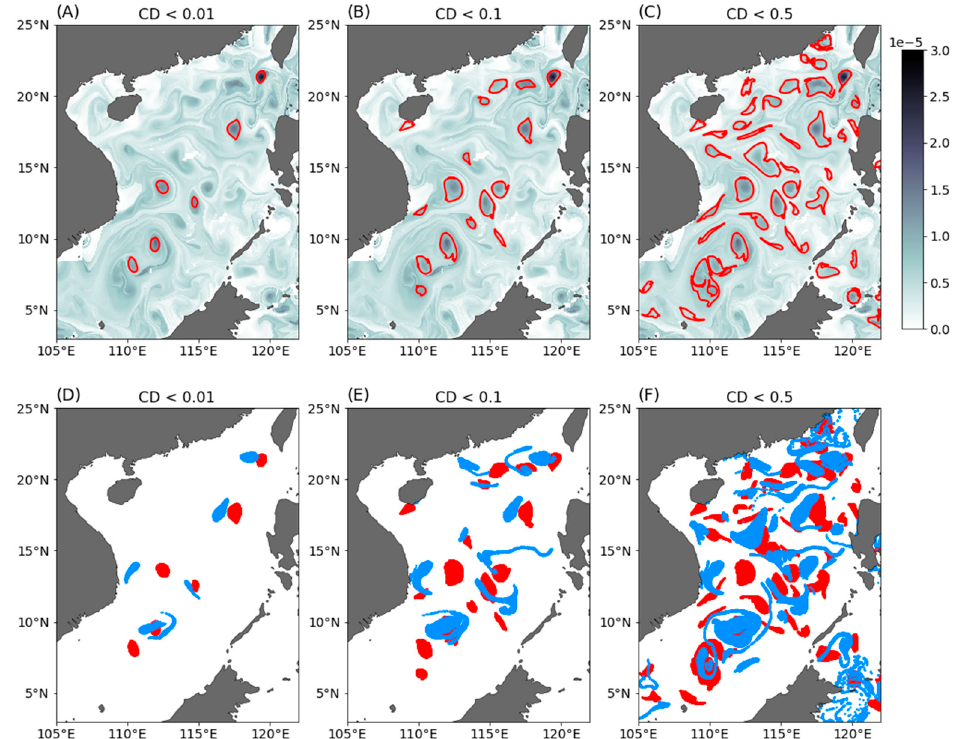
Figure A1. LAVD fields (colors) and 30-day Lagrangian eddy boundaries (red lines) for ( A ) CD < 0.01, ( B ) CD < 0.1, and ( C ) CD < 0.5 in a random time interval. Initial (red dots) and final (blue dots) locations for ( D ) CD < 0.01, ( E ) CD < 0.1, and ( F ) CD < 0.5.